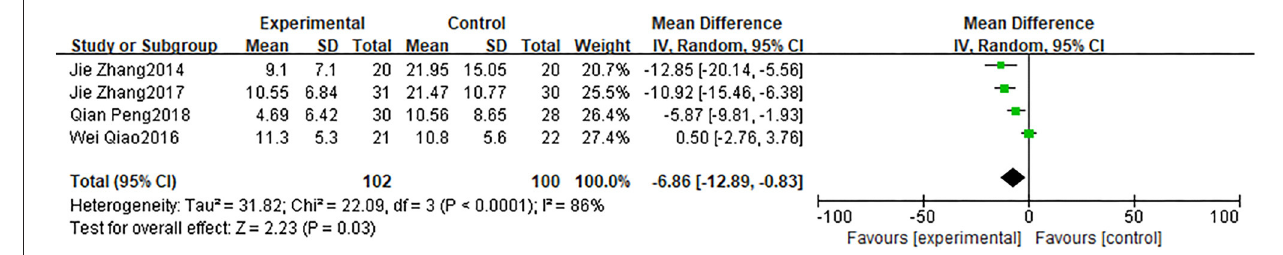
FIGURE 4 | Forest plot of decrease of diastolic blood pressure (DBP).